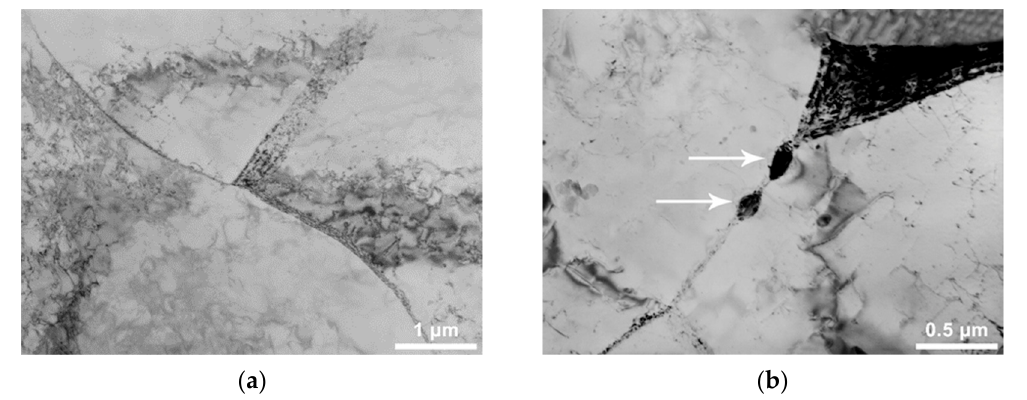
Figure 5. Microstructure of samples of the batches (TEM, bright-field images): ( a ) Polygonal ferrite (No. 1-1); ( b ) Cementite precipitation indicated by arrows (No.